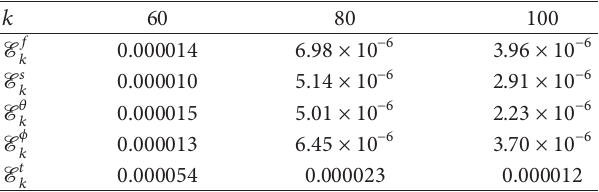
Table 2: Averaged squared residual errors using 𝑐 = −1.17 , and 𝑐 𝜙 −1.86 , 𝑐 𝜃 0 = 𝑁 = 𝑁 = 0.1 , and 𝑐 = 0.5 . 𝑁 𝑏 𝑡 𝑟